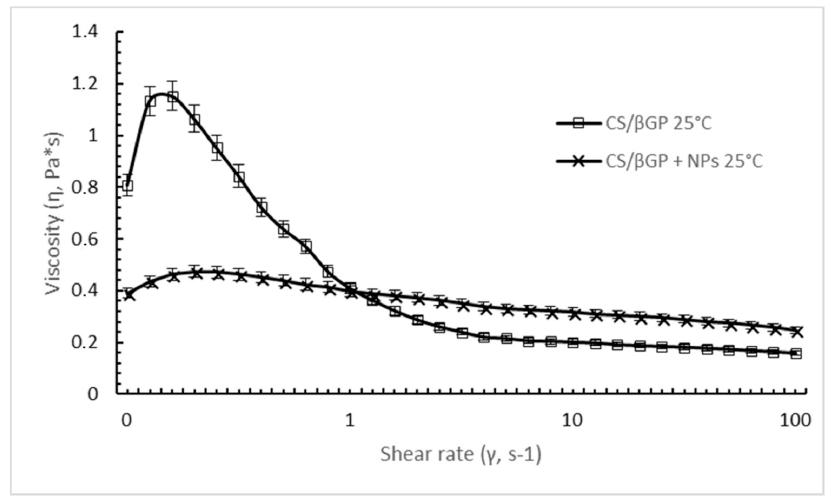
Figure 5. Shear rate viscosity (Pa*s) of thermosensitive CS/ β GP ( □ , empty square) and CS/ β GP with DXM loaded PLGA/PEG-PLGA NPs (X, cross) formulation as a function of shear rate applied (0.1–100 s − 1 ) at 25 °C.